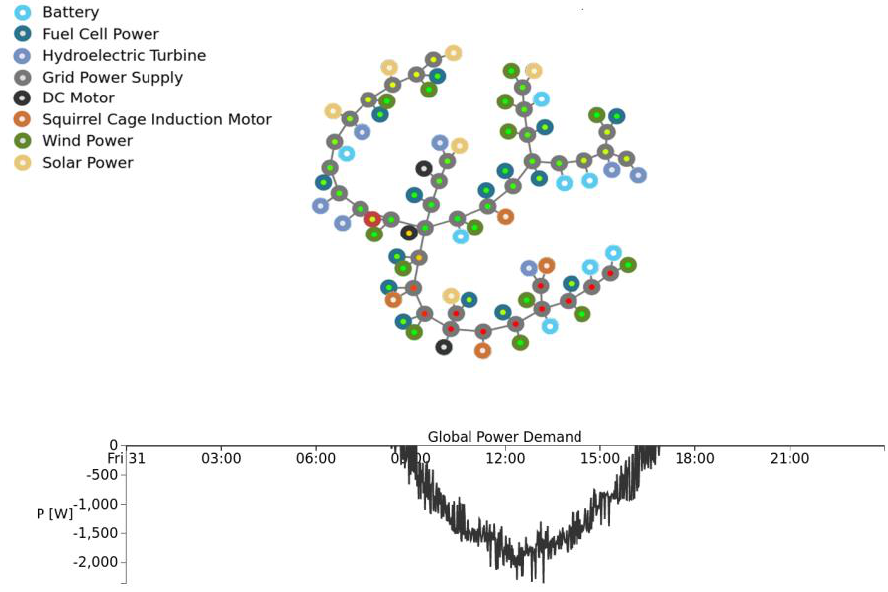
Figure 24. Mosaik co-simulation: SCIM RMS Voltage.